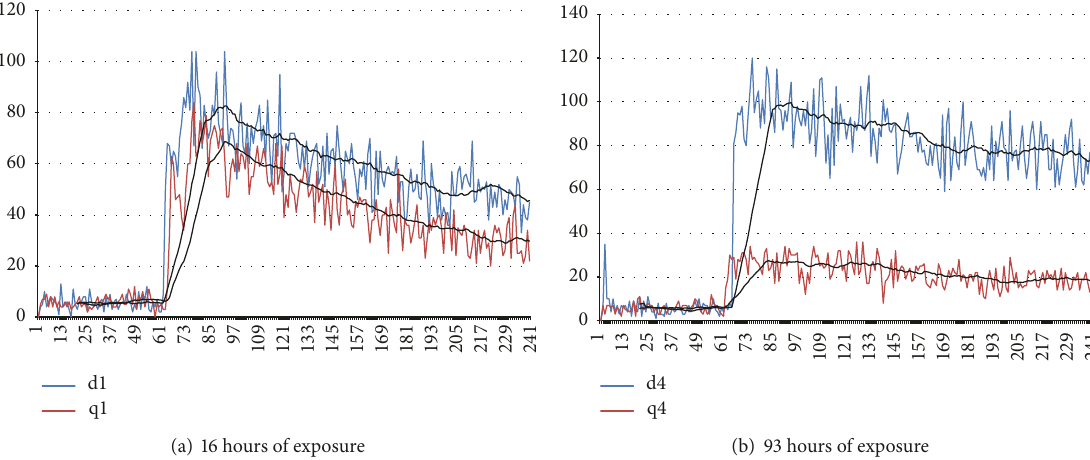
Figure 7: Results of the ultra-weak photon emission measurement of deionized water (blue line) and noncontact treated deionized water (red line), respectively . (a) 16 hours later. (b) 93 hours later. The antioxidant property levels of the noncontact treated water is about one-fourth of the